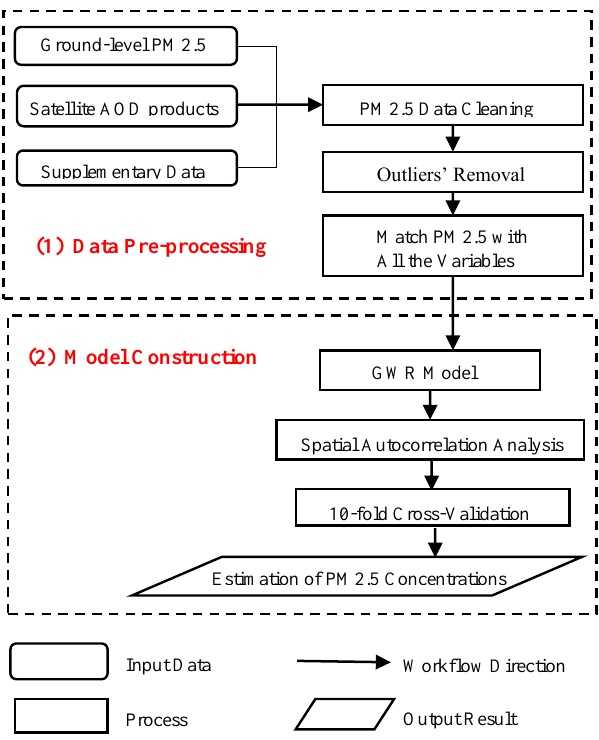
Figure 3. Workflow of the